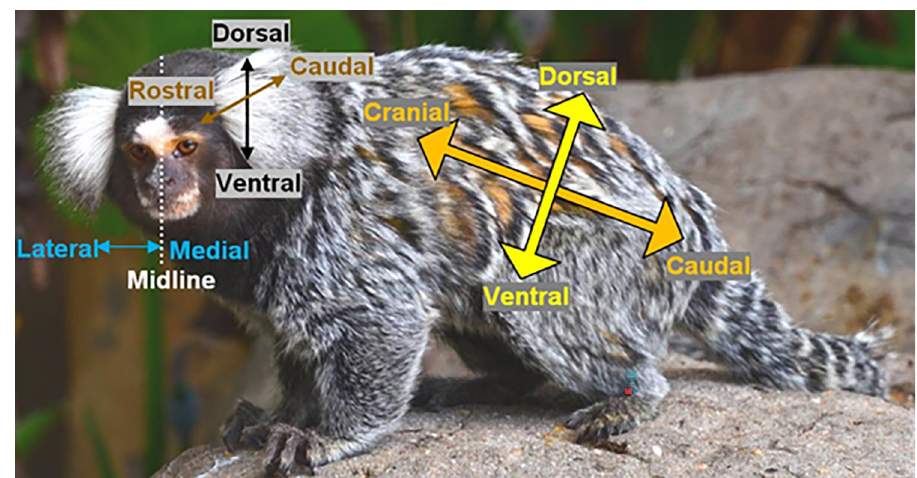
Fig 3. Spatial representation of directional terminology for a quadruped animal. Cranial : towards the cranium, along the long axis of the trunk (craniocaudal axis). Rostral : towards the apex of the nose, along the long axis of the head (rostrocaudal axis). Caudal : towards the tail or back of the head, along the long axis of the trunk or head, respectively. Dorsal : towards the spinal column or the top of the head, along the short axis of the trunk or the short axis of the head, respectively (dorsoventral axis). Ventral : towards the abdomen or the underside of the head, along the short axis of the trunk or the short axis of the head, respectively. Medial : towards the medial plane (represented by the midline ) of the body or head. Lateral : from the medial plane, towards the left or right side of the body or head. These terms can be combined to describe a movement in additional directions, as for example: dorsocaudal, ventrocaudal, dorsocranial, ventrocranial.